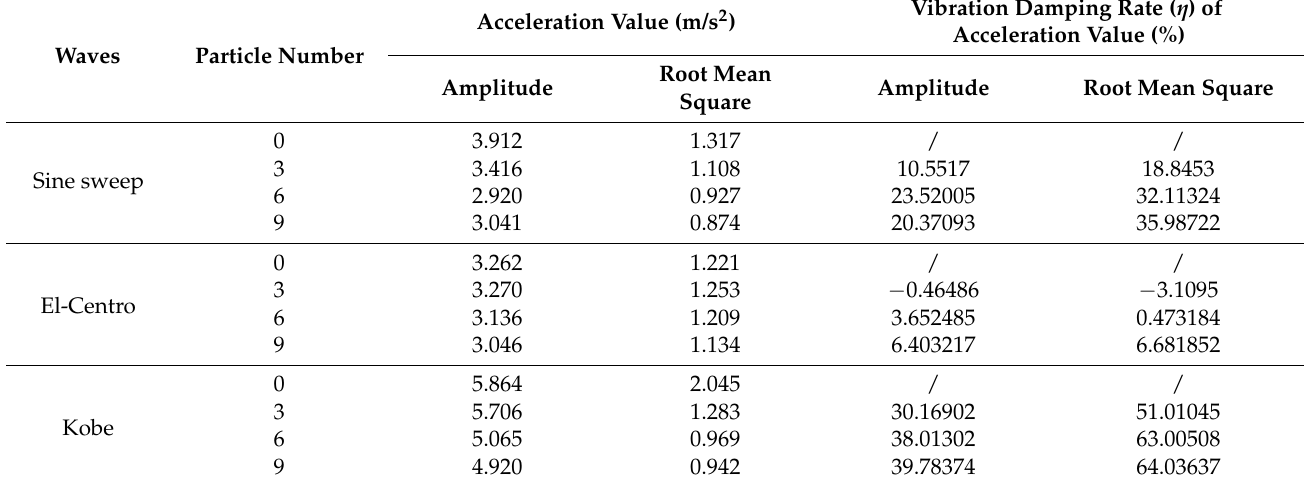
Table 3. Acceleration Response (mass ratio: 2%).